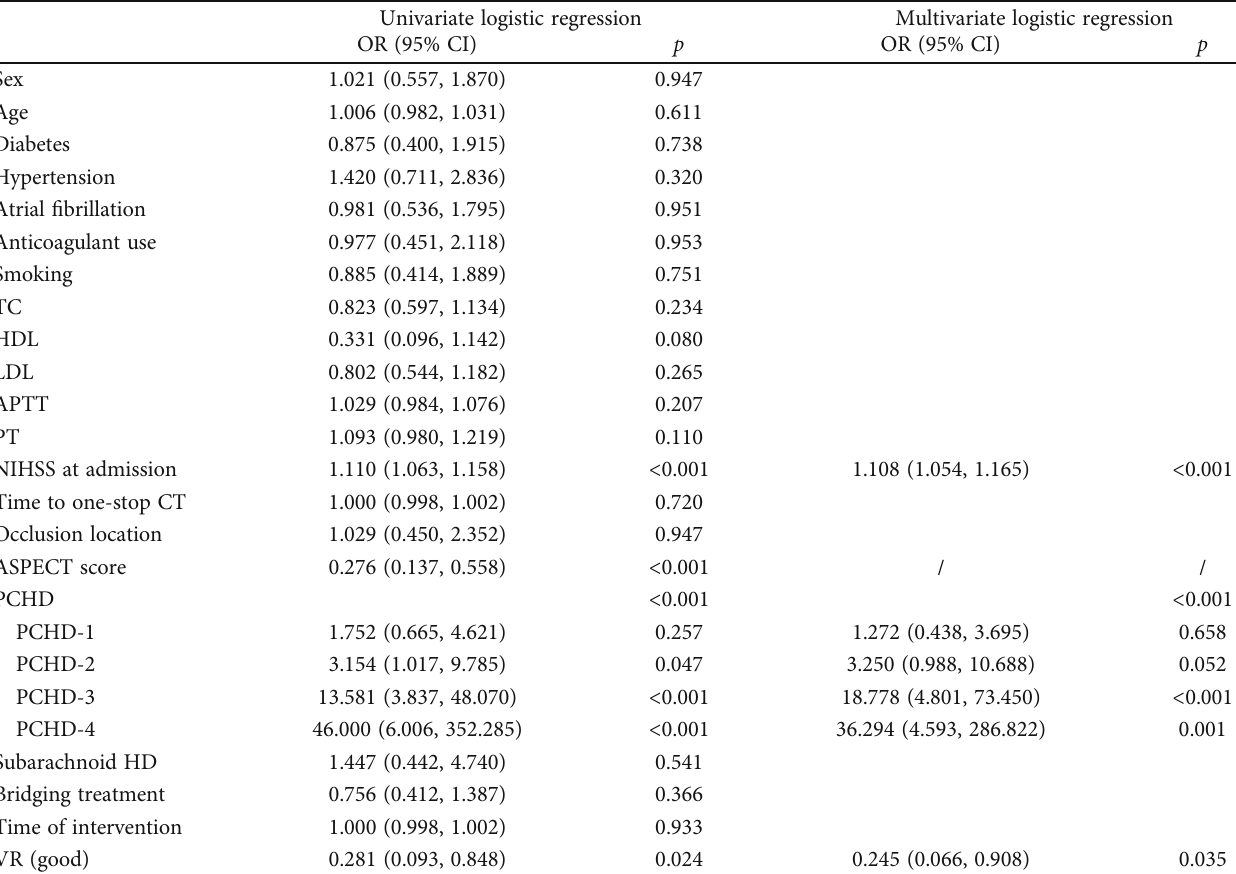
Table 4: Stepwise logistic regression analysis predicting mRS score at 3